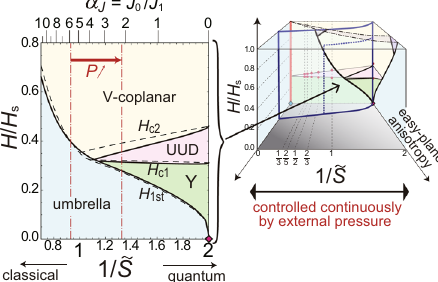
Fig. 10 Phase diagram in an extended parameter space. Theoretical ground-state phase diagram of the model for CsCuCl 3 in the plane of magnetic fi eld H scaled by the saturation value H s and the reciprocal of the effective spin ~ S . The solid and dashed curves in the left panel are the phase boundaries obtained for the original model of CsCuCl 3 with the ratio of the intralayer to interlayer interaction, α J and the effective 2D model with the corresponding values of the effective spin ~ S , respectively. The range of the pressure application in the current experiments is indicated by the vertical red dashed-dotted lines. The right illustration schematically shows the corresponding parameter plane in the three-variable phase diagram for 2D easy-plane triangular-lattice antiferromangets, shown in Fig.